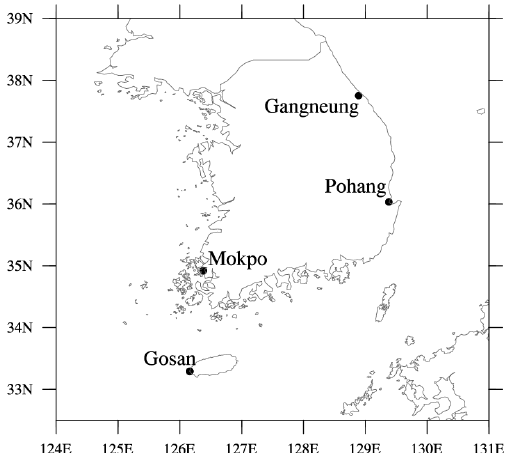
Figure 1. Spatial distribution of analysis sites (Gangneung, Pohang, Mokpo, and Gosan) in South